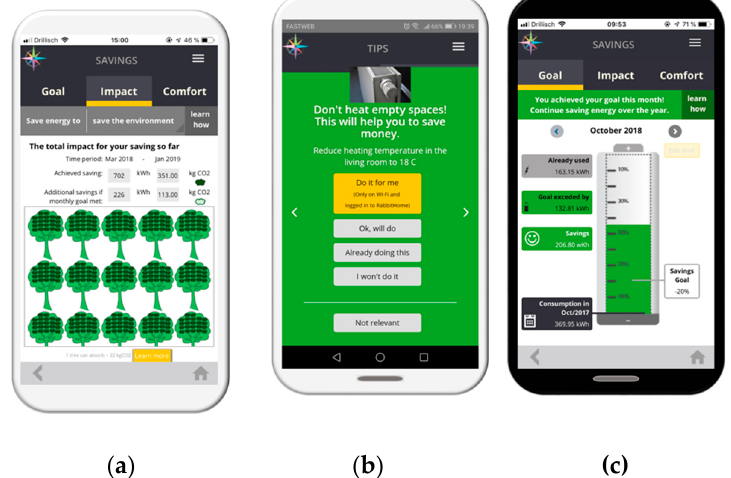
Figure 2. Examples of enCOMPASS pages: ( a ) environmental impact visualization page; ( b ) tips page; ( c ) goal monitoring